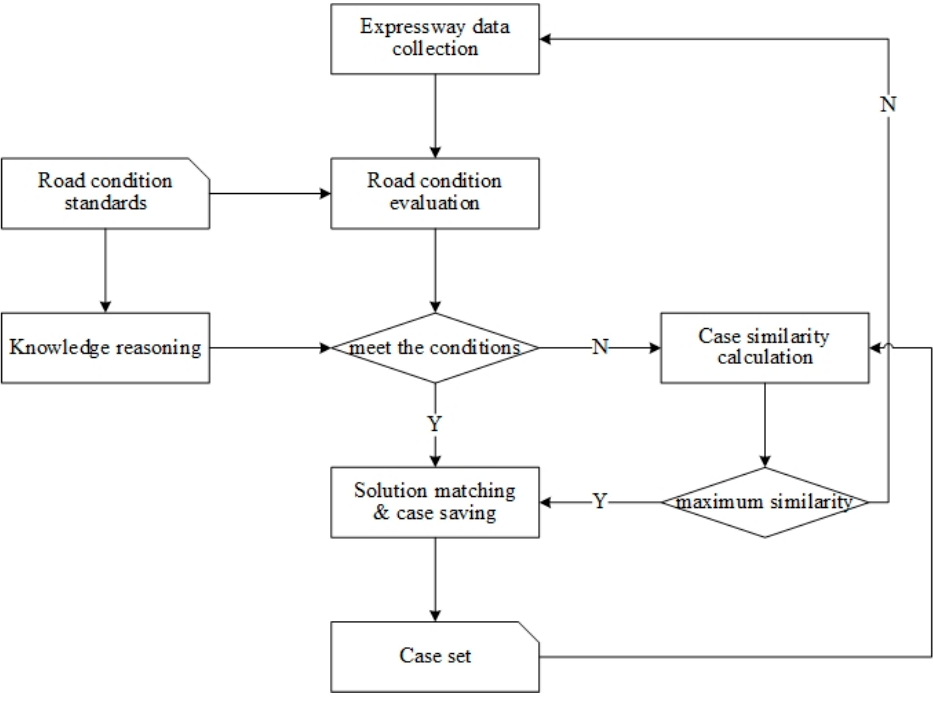
Figure 4. The decision-making process of urban expressway renewal.